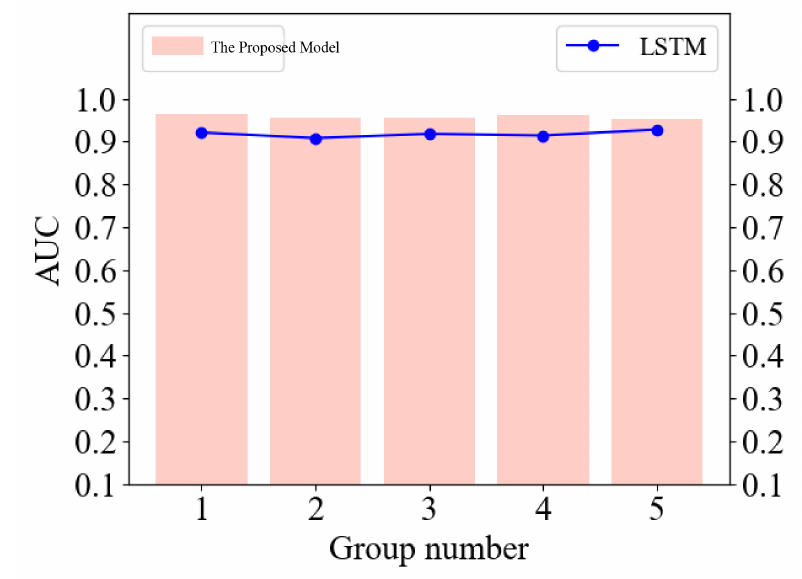
Figure 13. Comparison with the AUC of LSTM